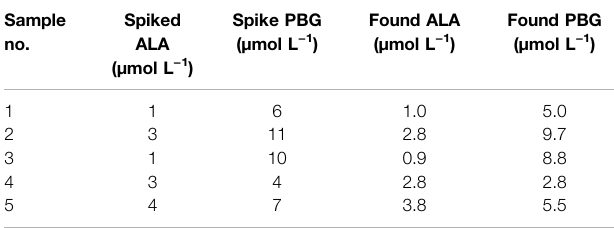
TABLE 1 | Urine samples spiked with δ -ALA and PBG and obtained concentrations. Sample